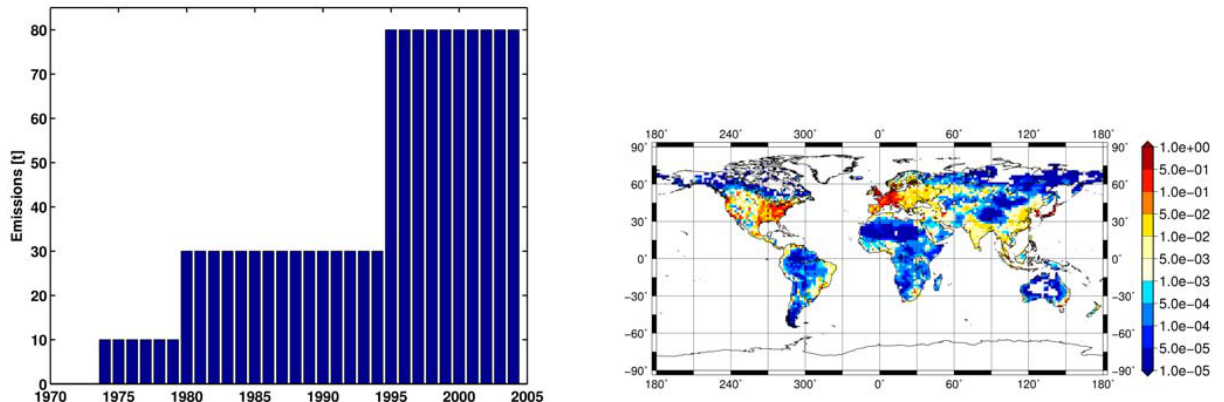
Fig. 2. FTOH emissions: temporal [ta − 1 ] and spatial [ta − 1 , 1 ◦ × 1 ◦ ]